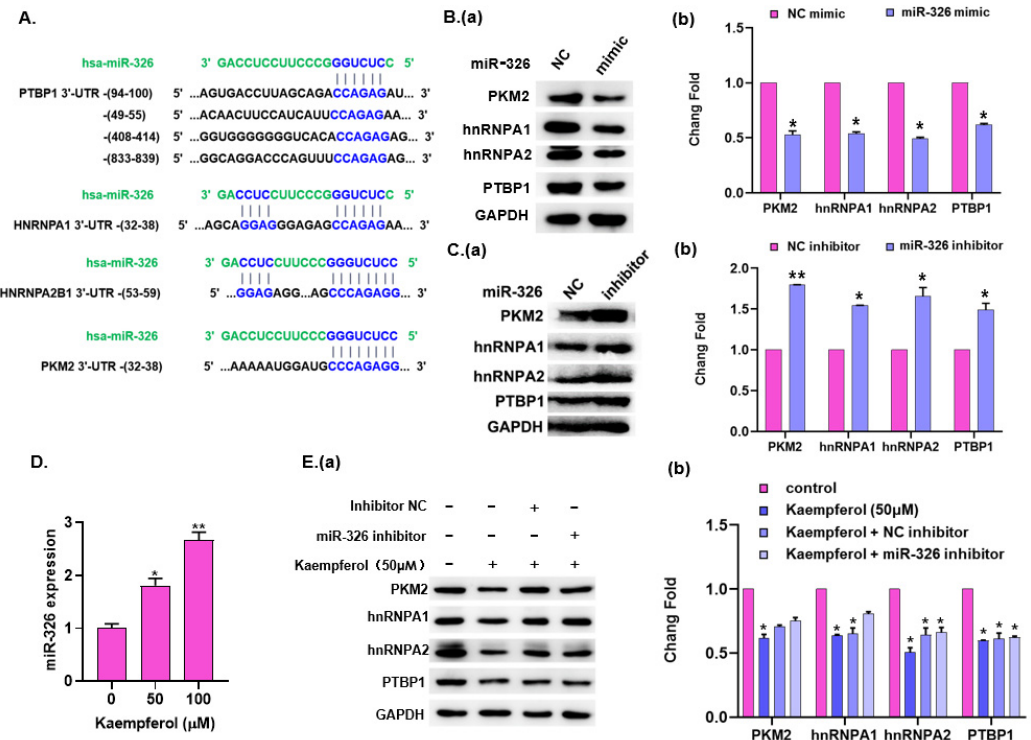
Figure 5. Kaempferol regulates PKM2 expression through miR-326. ( A ) The seed sequence of miR-326 (microRNA-326) matched with the 3 ′ -UTR (untranslated region) of hnRNPA1/A2/PTBP1/PKM2. ( B ) The expression of hnRNPA1/A2/PTBP1 and PKM2 proteins in HCT8-R cells was analyzed, 48 h after miR-326 transfection, by Western blot. ( a ) A representative result from three independent experiments is shown. ( b ) The densitometry analysis of relative protein expression is shown in a histogram. ( C ) Western blot was used 48 h after the transfection of miR-326 inhibitor to analyze the expression of hnRNPA1/A2/PTBP1 and PKM2 in HCT8-R cells. ( a ) A representative result from three independent experiments is shown. ( b ) The densitometry analysis of relative protein expression is shown in a histogram. ( D ) After HCT8-R cells were treated with different concentrations of kaempferol, the expression of miR-326 was analyzed by qPCR. ( E ) HCT8-R cells were treated with kaempferol alone or in combination with miR-326 inhibitor, and the expressions of hnRNPA1/A2/PTBP1 and